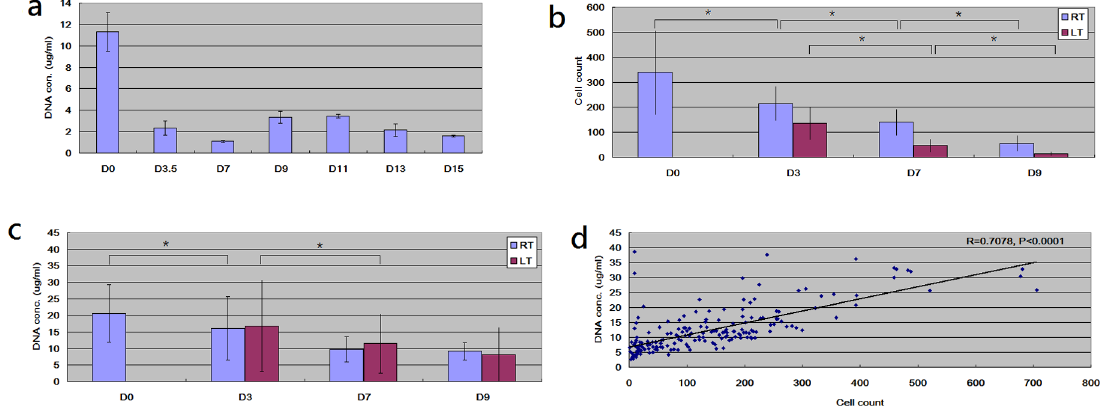
Fig 3. Examinations of WBC count and DNA concentration on samples with different storage temperature and storage duration. * denotedsignificanceby t-test. All data was presented as mean ± SD. (a) X axis represented different storage durationsof wholeblood. For example,D0 denotedthat whole bloodwas processed immediately after collected;D7 denoted that wholeblood was stored for 7 days before further processing. All blood samples were collectedfrom one singlesubject and stored at 24˚C. For each durationpoint, three blood samples were collected(N = 3). (b,c) With longerduration, more WBCs lysed and less DNA was collectedfrom cell pellets. Thirty blood sampleswere collectedfrom 10 subjects(N = 30). (d) WBC number and DNA concentration were highly correlated, showingthat decreased DNA collectionwas resulted from WBC lysis. Scatter plot was generated from 199 data points (7 * 30= 210, excludingseveral failed samples).